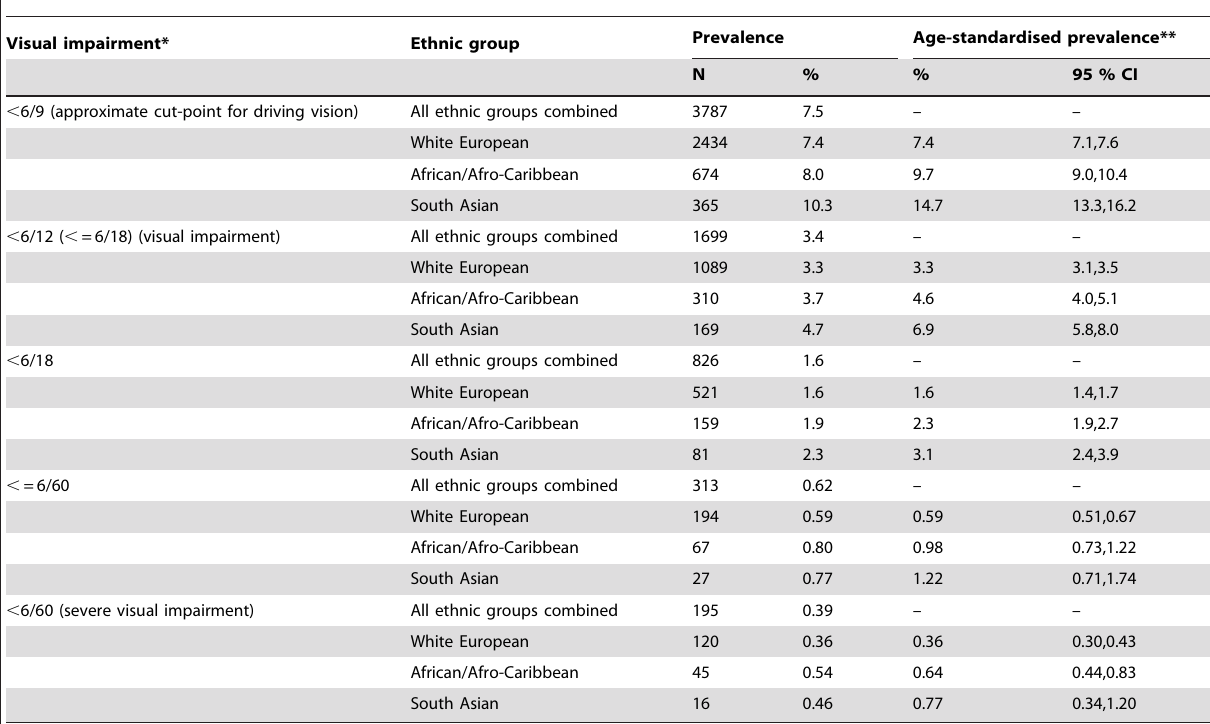
Table 4. Prevalence of visual impairment in people with